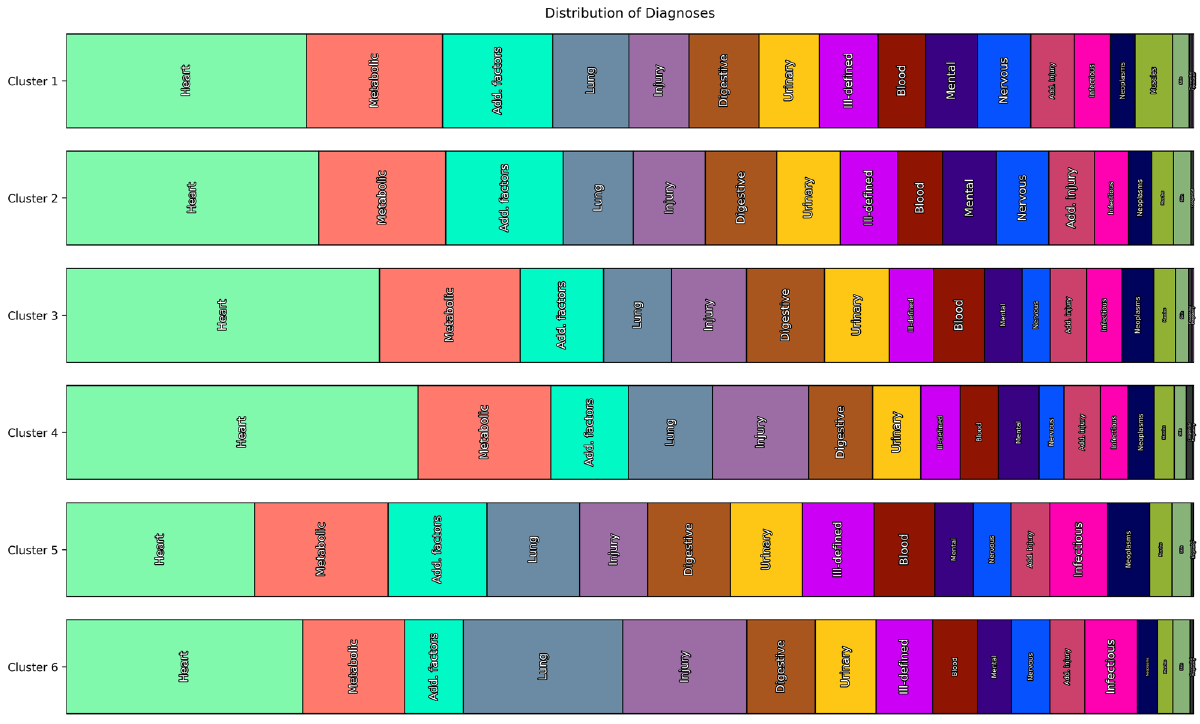
Figure 4. Distribution of ICD categories within the primary clustering ( k = 6 ). For each clustering, we examine every diagnosis code assigned to any patient and count it towards the ICD group to which it belongs. Every diagnosis is counted, even if a single admission exhibits multiple diagnoses from the same ICD category. Clusters 1 and 2 appear very similar concerning ICD categories; they differ more strongly on lower levels of the ICD tree. Cluster 4 has the highest fraction of heart-related diagnoses, while Cluster 6 contains the most injuries. Note that total diagnosis counts are different between clusters, but the bars in the figure are normalized to the same length to enable an easier